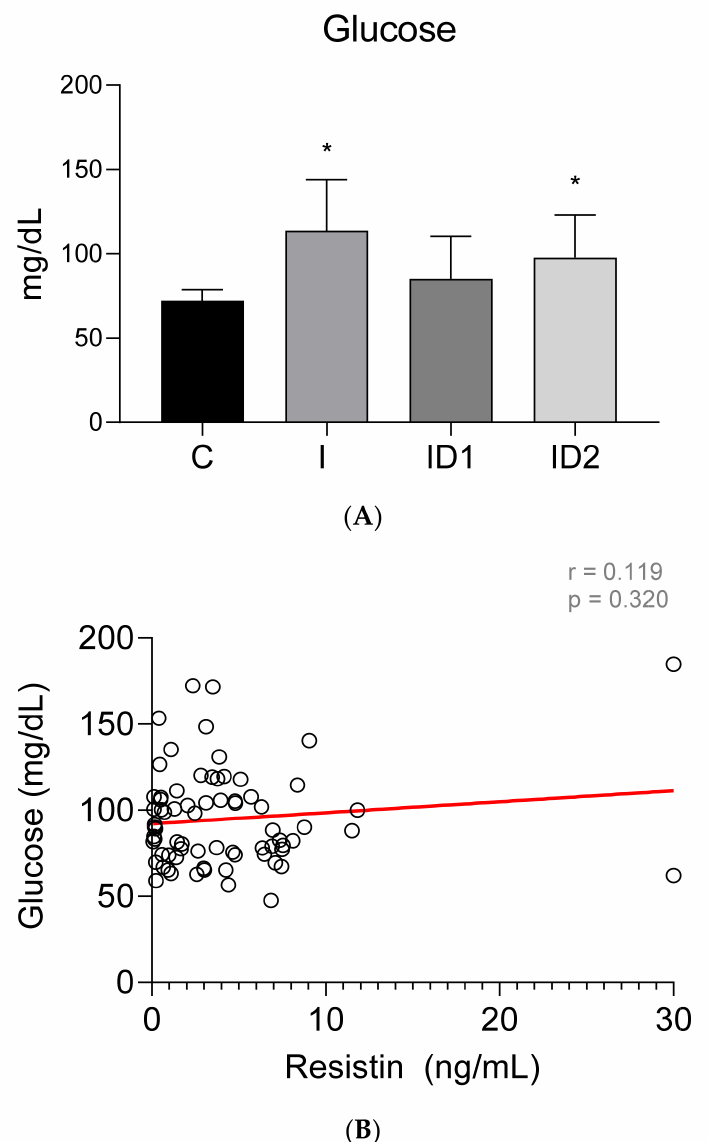
Figure 2. ( A ) Plasma glucose concentration (mg/dL) in the different groups. Control group (C) n = 14, inflammatory group (I) n = 21, mild insulin dysregulation group (ID1) n = 18, severe insulin dysregulation group (ID2) n = 19. Bars represent mean + SD. Asterisks indicate significant differences with the control group (* p < 0.05). ( B ) Correlation between plasma glucose concentration (mg/dL) and plasma resistin concentration (ng/mL) in 72 horses. The linear regression line is draw red solid (n = 72, r = 0.119, p =